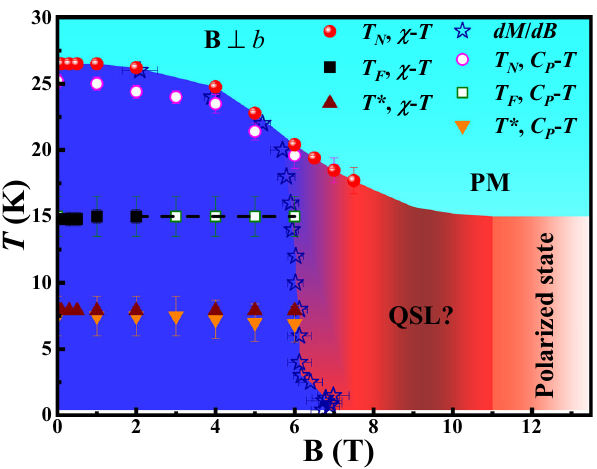
Fig. 4 Phase diagram of Na 2 Co 2 TeO 6 . Temperature – magnetic fi eld phase diagram for NCTO. The stars symbol the fi rst-ordered phase boundary. The color background is used only as a